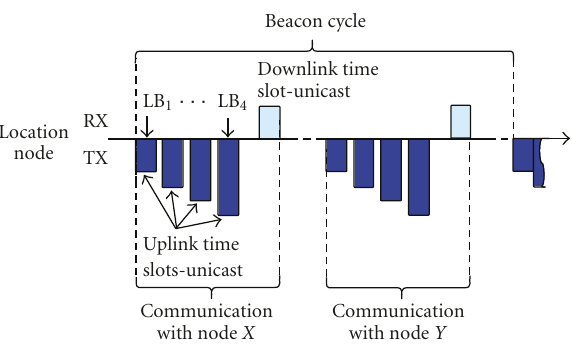
Figure 11: Location node beacon cycle using